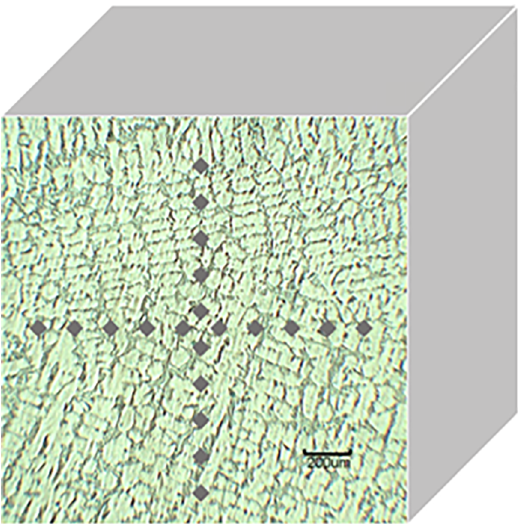
Figure 4. Representative scheme of HV measurements in as-cast and heat-treated samples of the investigated alloy in this work.